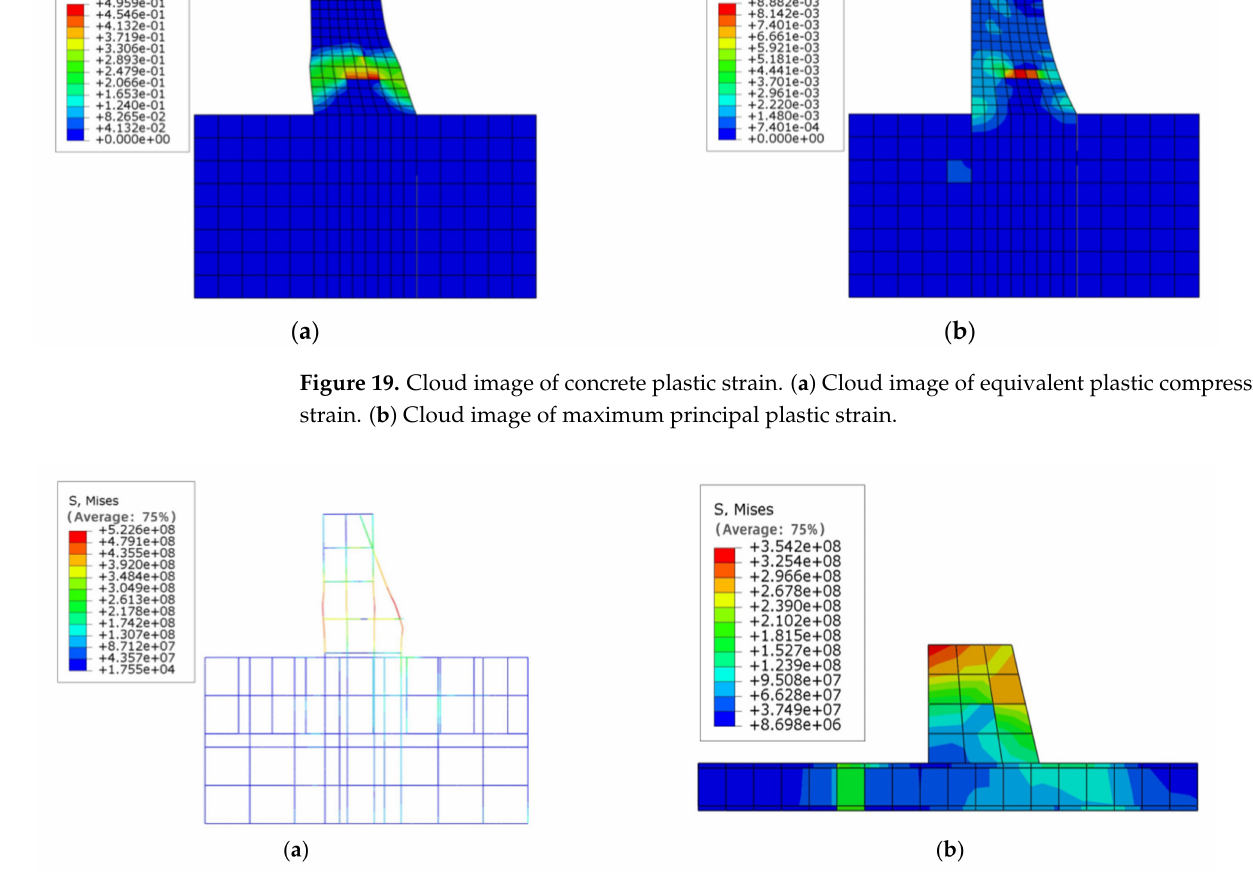
Figure 20. Cloud image of steel bars and steel plate plastic strain. ( a ) Cloud image of equivalent plastic compressive strain. ( b ) Cloud image of maximum principal plastic